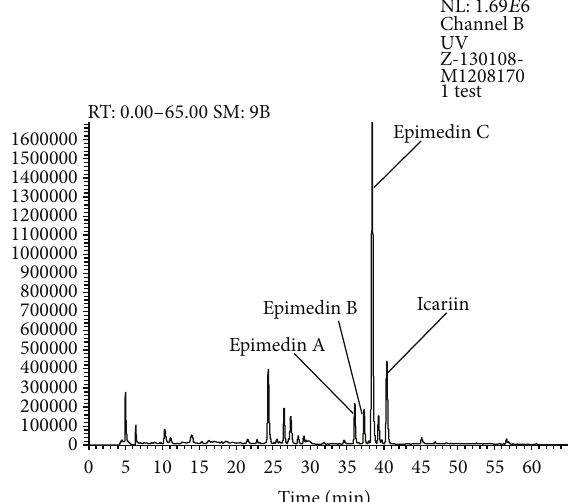
Figure 1: HPLC-DAD fingerprinting of purified Herba Epimedii extract (CKZ) at 270